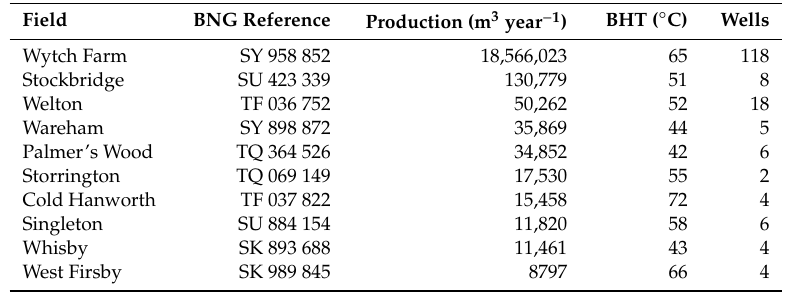
Table 3. The ten most favourable onshore hydrocarbon fields for geothermal